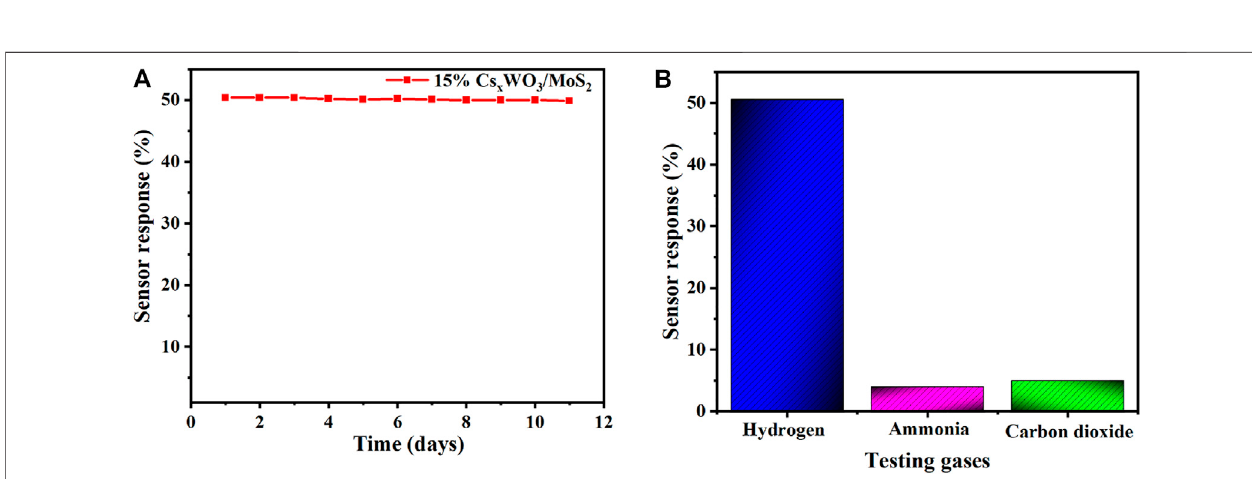
FIGURE 8 | (A) long-term stability, and (B) selectivity of the 15% Cs x WO 3 /MoS 2 -based hydrogen gas sensor.